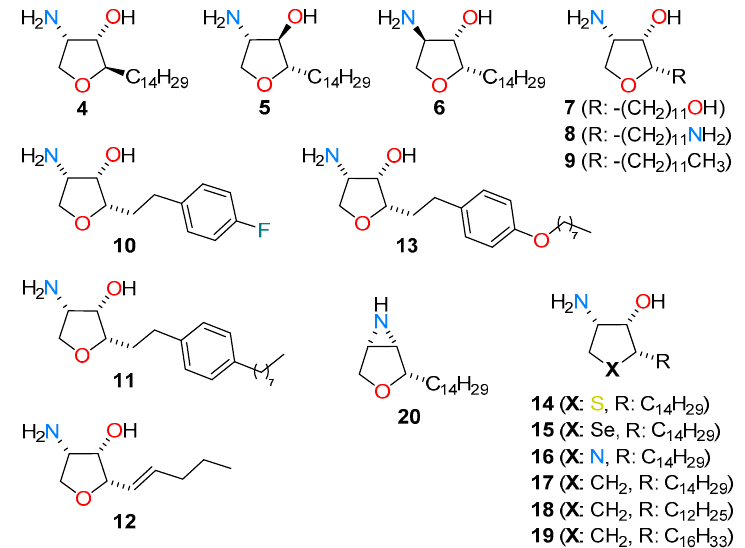
Figure 2. Synthetic derivatives of jaspine B 1 .